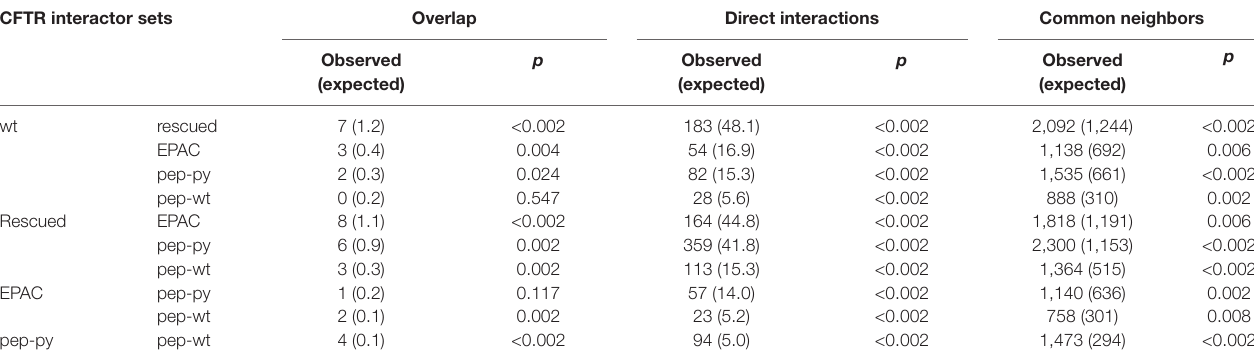
TABLE 2 | Overlap, direct interactions, and common neighbors between CFTR interactor sets. CFTR interactor sets